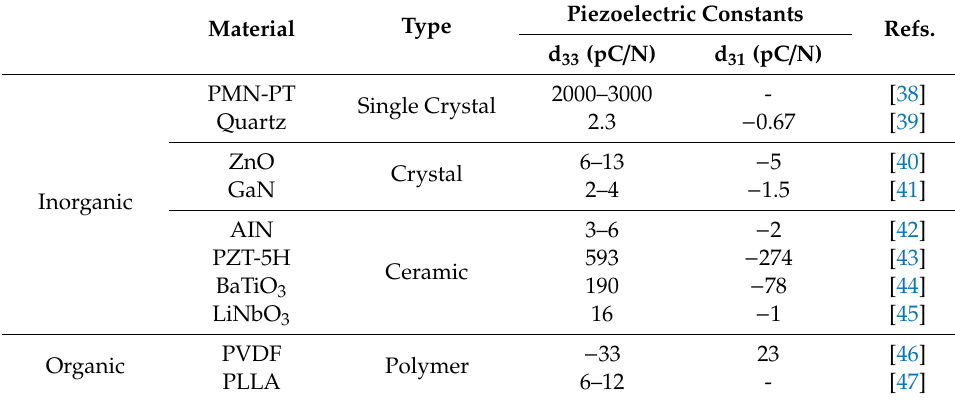
Table 2. Piezoelectric coefficients for different piezoelectric inorganic and organic materials.